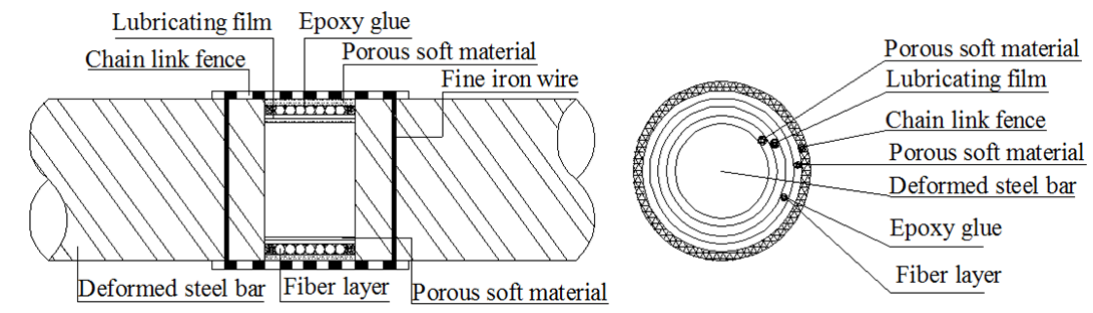
Figure 6. Packaging structure of